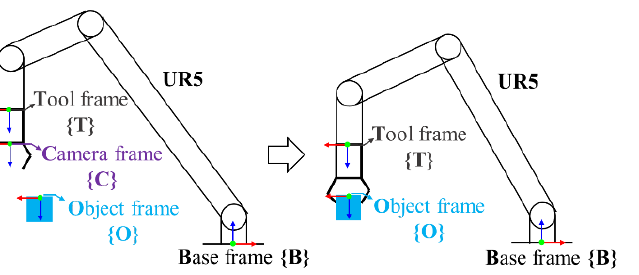
Figure 23. Relationship of coordinate frames of the manipulator, the gripper/camera system, and the object.